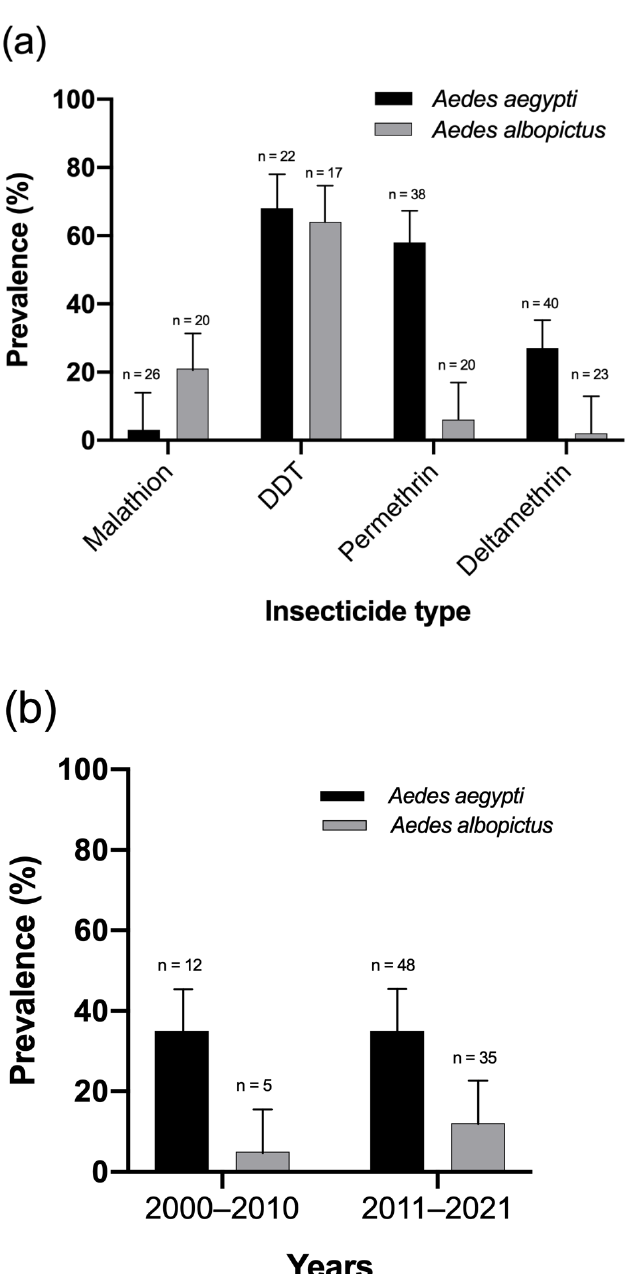
Figure 6. ( a ) Meta-analysis results of the summarized insecticide resistance rates. ( b ) Subgroup meta-analysis of insecticide resistance rates for the two time